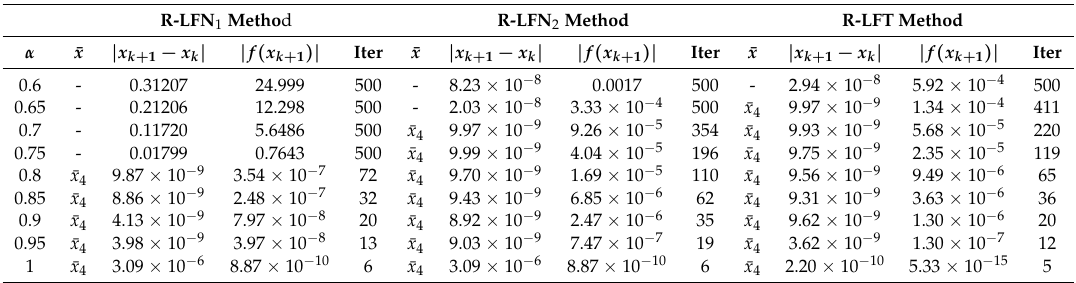
Table 2. Fractional Newton and Traub-type results for f 1 ( x ) with Riemann–Liouville derivative and initial estimation. x 0 = − 1.5.